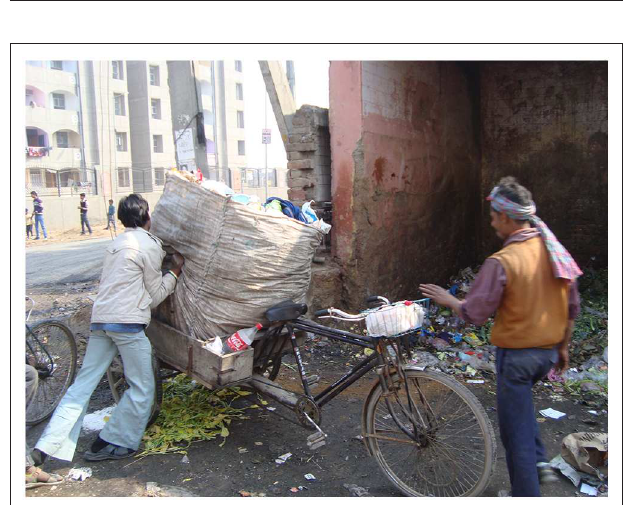
FIGURE 4 | Collected waste is transported to “khatta” (community